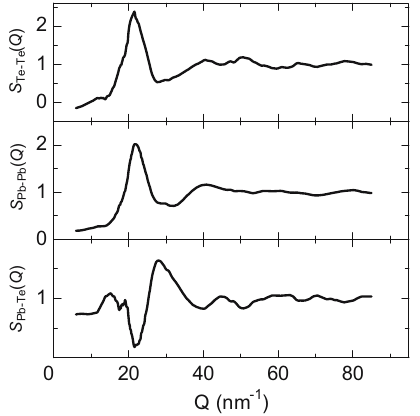
Figure 2: Estimated partial structure factors, ( ) S Q ij ’ s ( i , j = Pb and Te ) , by using ( ) S Q obs ’ s.